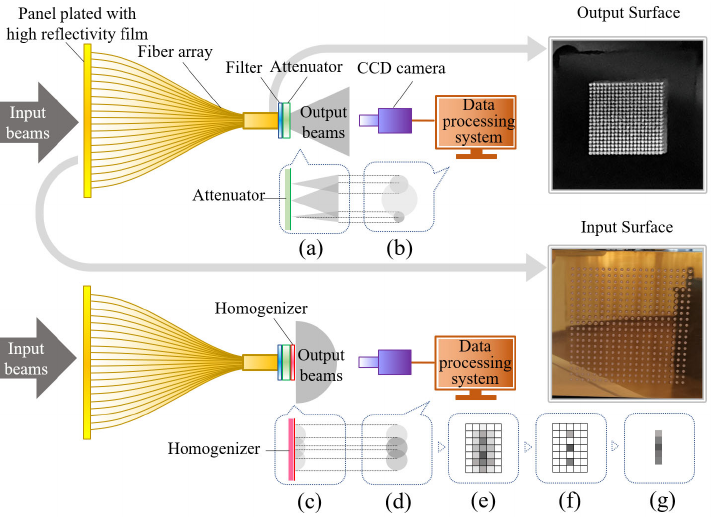
Figure 3. System diagram: the upper half of the diagram shows the light transmission process without the homogenizer (part of the spots of the array), while the lower half shows the process